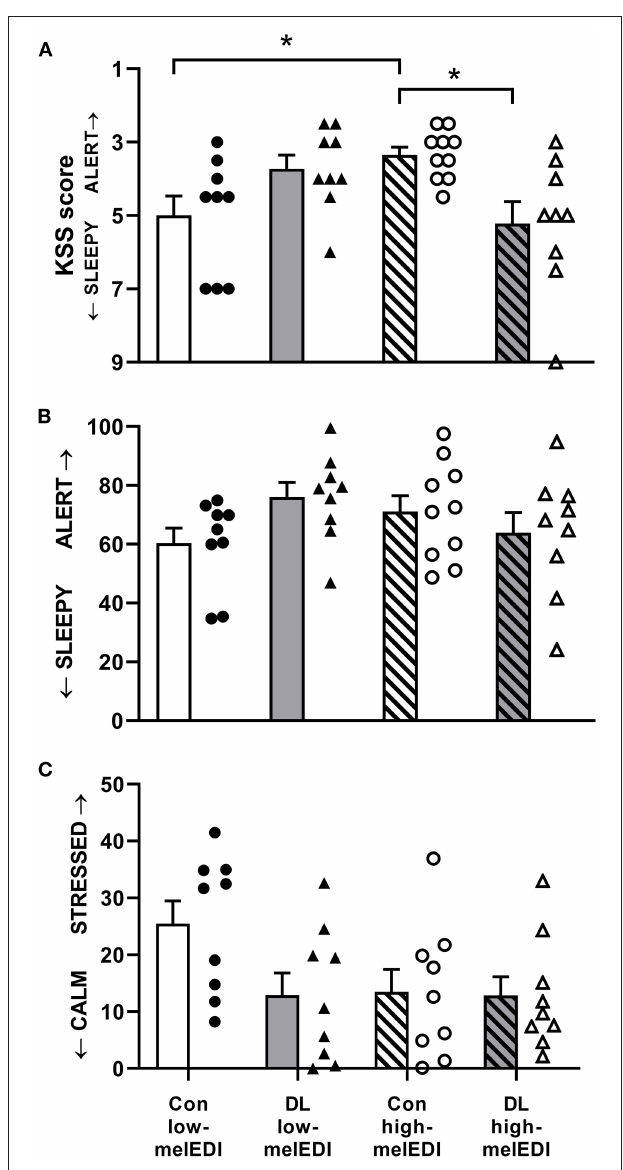
FIGURE 3 | Subjective sleepiness, alertness, and stress for each light exposure condition. Mean SEM of KSS sleepiness scores (A) , VAS alertness ± ratings (B) , and VAS stress ratings (C) . Individual participant data are shown for conventional low-melEDI (•), daylight-like high-melEDI ( N ), conventional high-melEDI ( ), and daylight-like melEDI ( 1 ) light conditions. KSS, Karolinska ◦ sleepiness scale; Con, Conventional; DL, Daylight-like. *denotes a significant difference between light